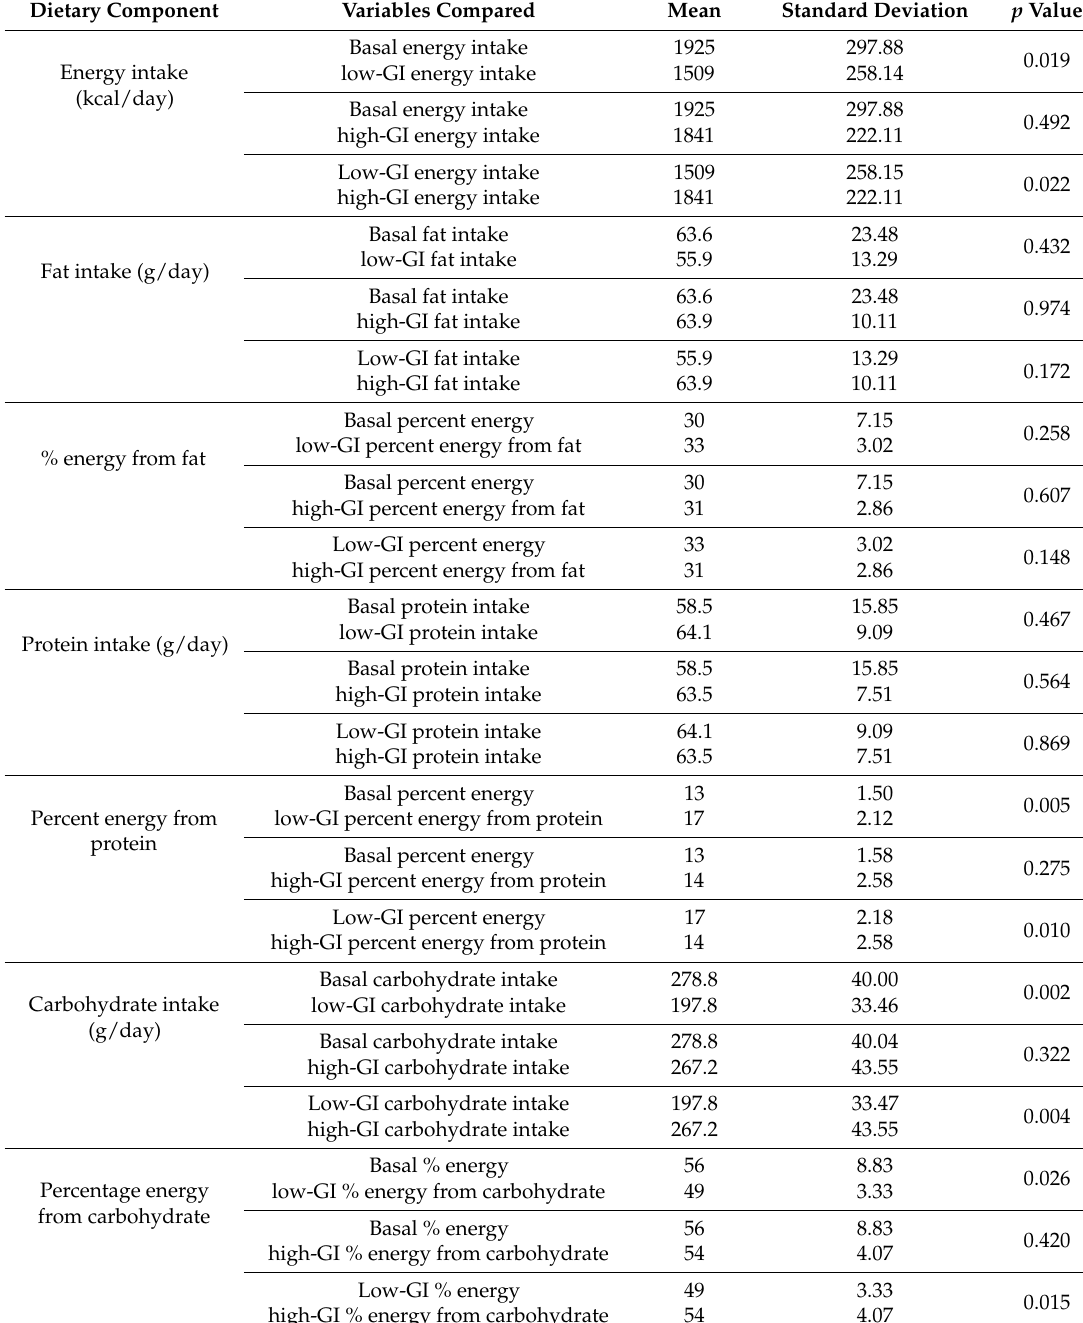
Table 3. Dietary components on basal, low-GI and high-GI